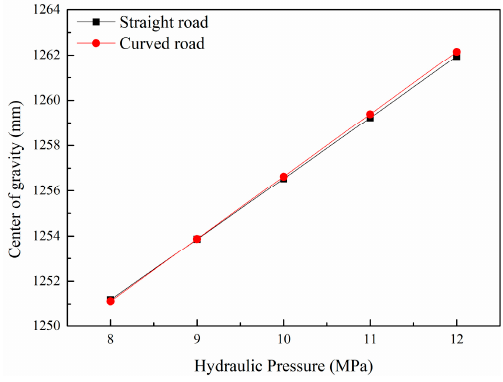
Figure 10. Z coordinate of the center of gravity under different hydraulic pressure.